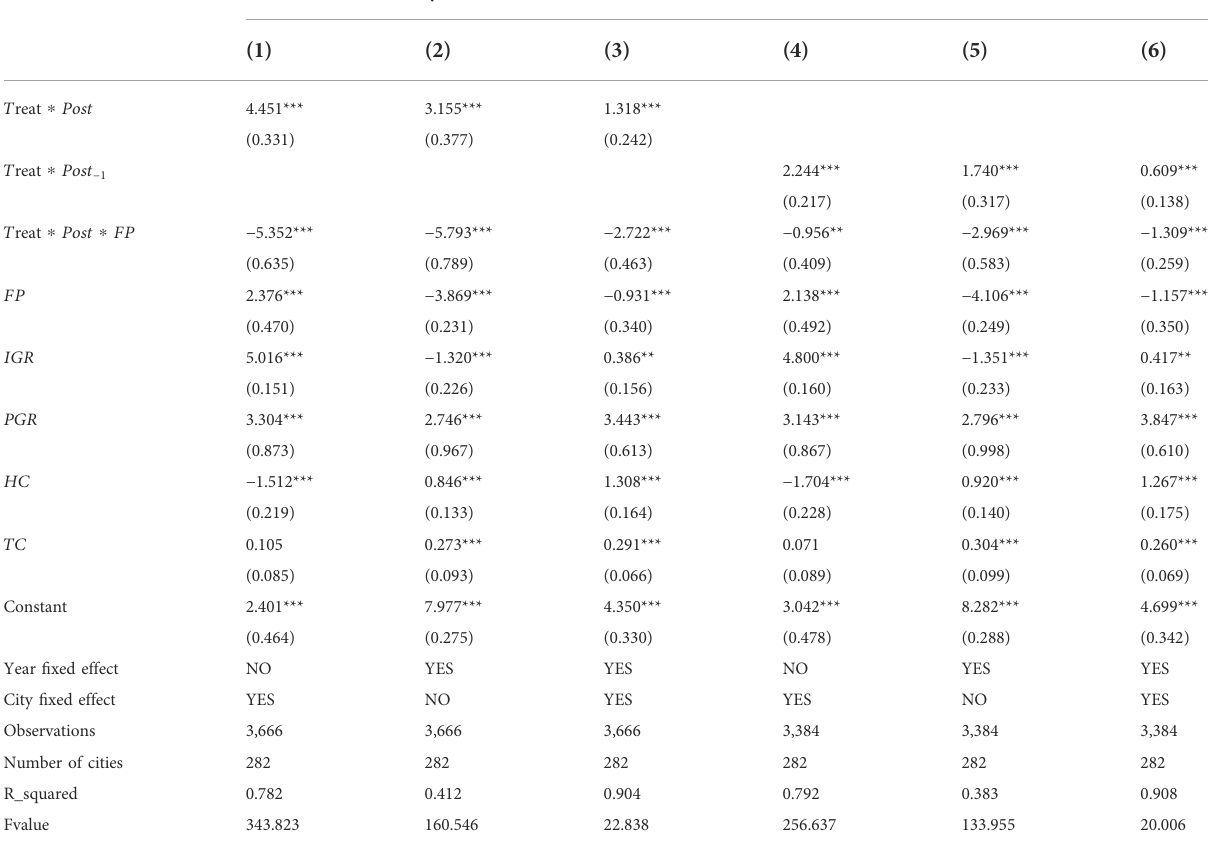
TABLE 3 Benchmark estimation